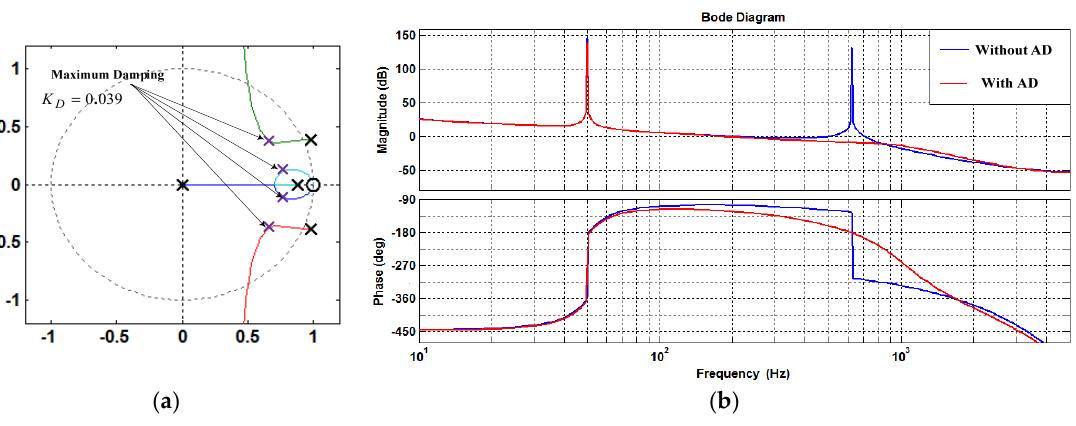
Figure 14. ( a ) Root locus maximum damping gain K D selection; and ( b ) Bode plots. ( K P = 0.0261, C f = 36 μ F, K D = 0.039).